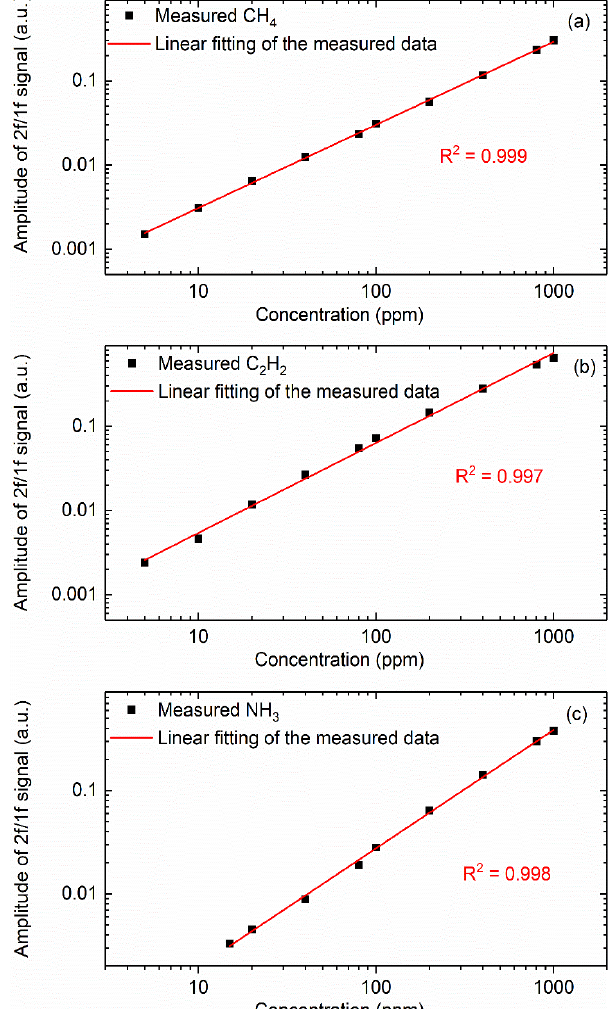
Figure 6. Measured amplitude of 2 f/1f signal as a function of the gas concentration: ( a ) CH 4 , ( b ) C 2 H 2 , ( c ) NH 3 .